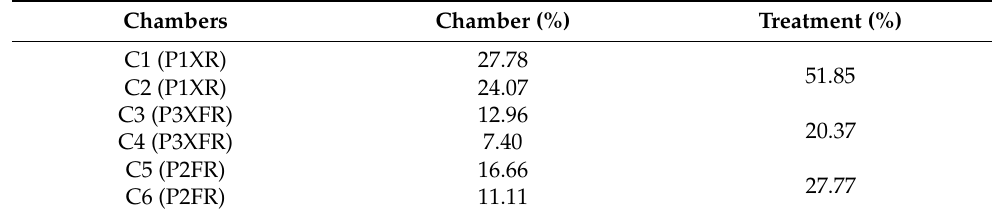
Figure 4. Distributions of A. bimaculatus (twospot Astyanax ) fish in the control assay (using well water) and in the assay with exposure to river water (C1 and C2 = P1XR; C3 and C4 = P3XFR; C5 and C6 = P2FR).